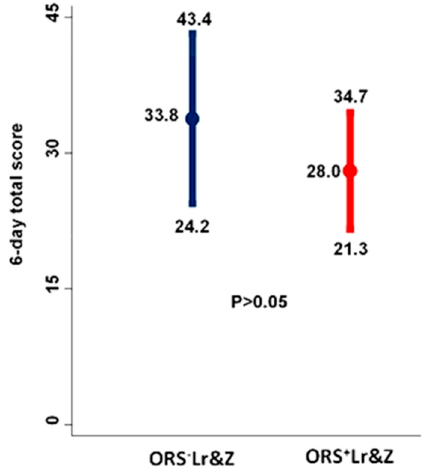
Figure 3. Total six-day severity score of diarrhoea. Results are presented with means and 95% confidence intervals. Comparisons between the ORS + Lr&Z and the ORS - Lr&Z arms were performed by the Mann-Whitney U test ( p > 0.5).